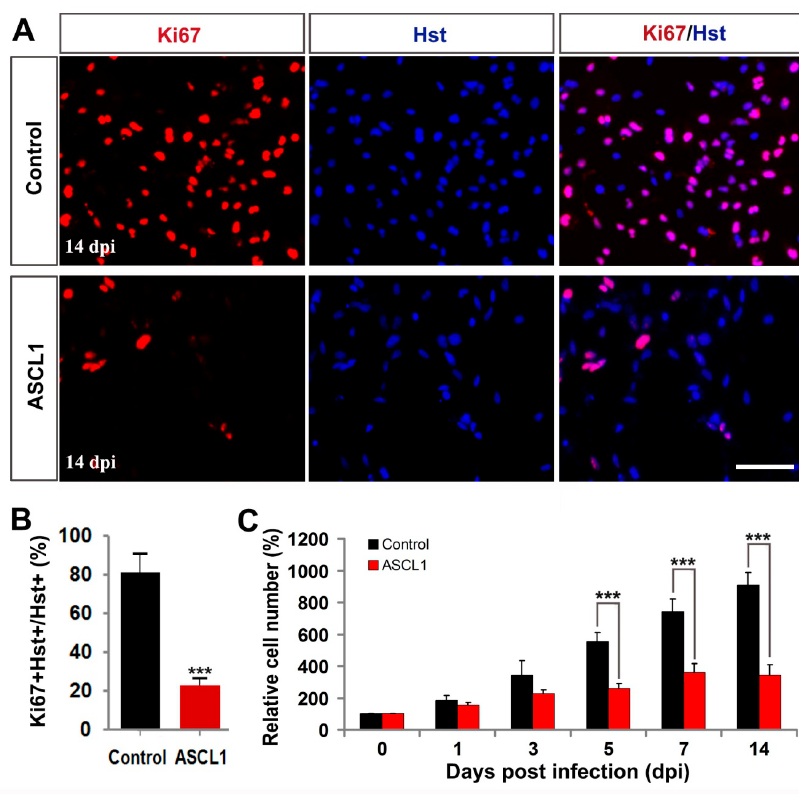
Figure 7. ASCL1-mediated neuronal reprogramming significantly inhibited glioma cell proliferation. ( A , B ) Immunocytochemical analysis of the proliferation of U251 cells by Ki67 staining at 14 dpi (n = 20 randomly selected fields from triplicate samples). ( C ) Time-course cell counting at zero, one, three, five, seven, and 14 dpi. *** P < 0.001 by Student’s t -test. Scales = 100 µ m.